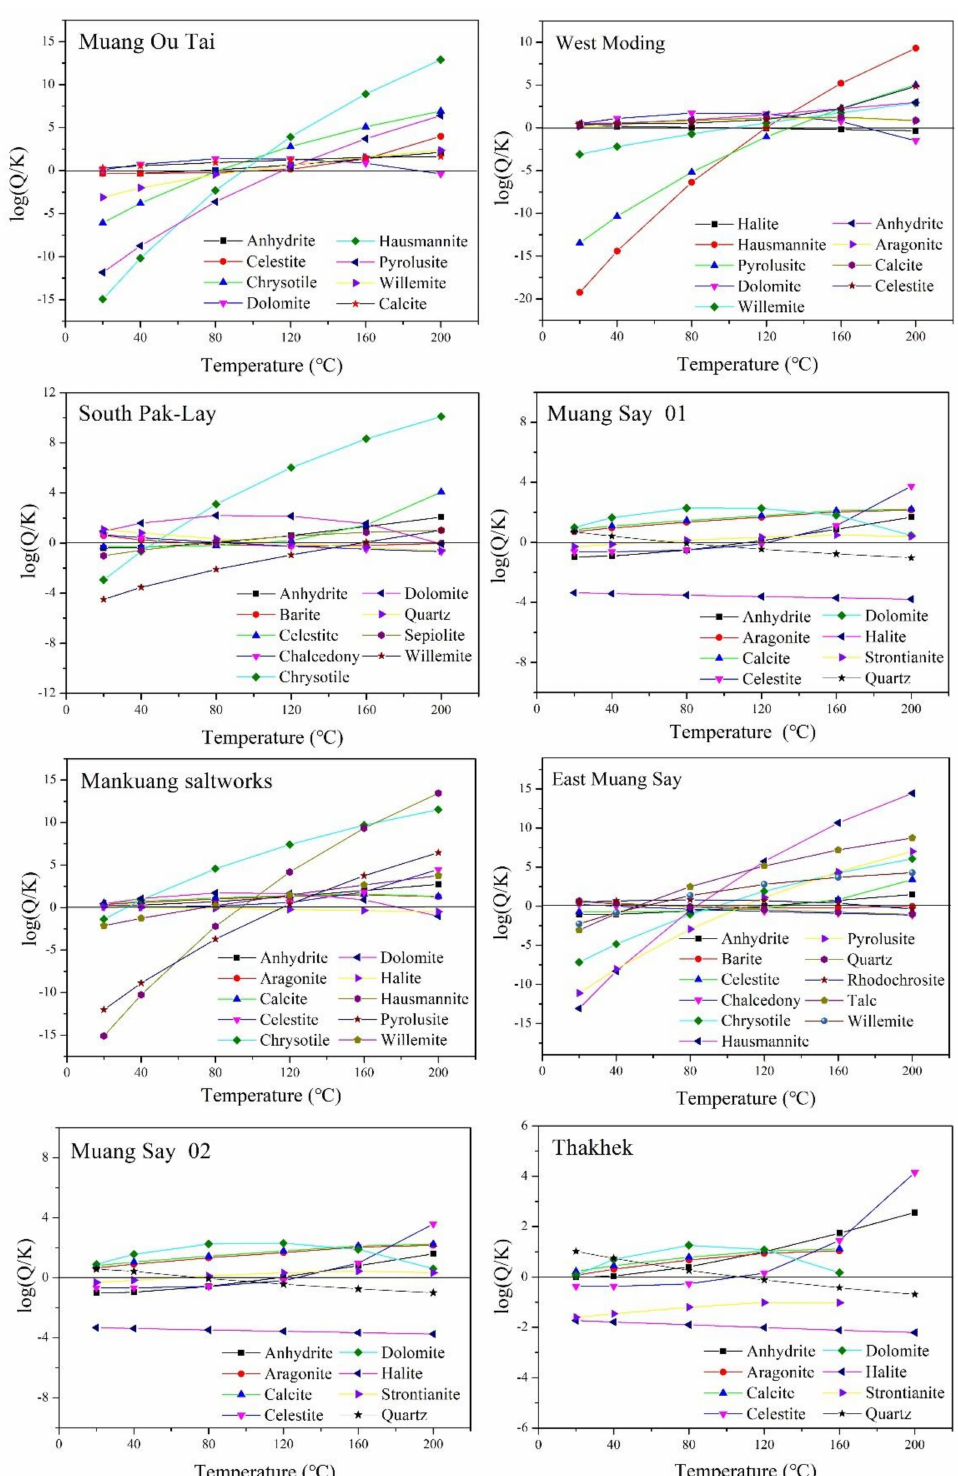
Figure 11. Log(Q/K)–T diagram showing saline springs from the north and central Laos (Q is the ion activity product; K is the equilibrium constant of the mineral at the equilibrium